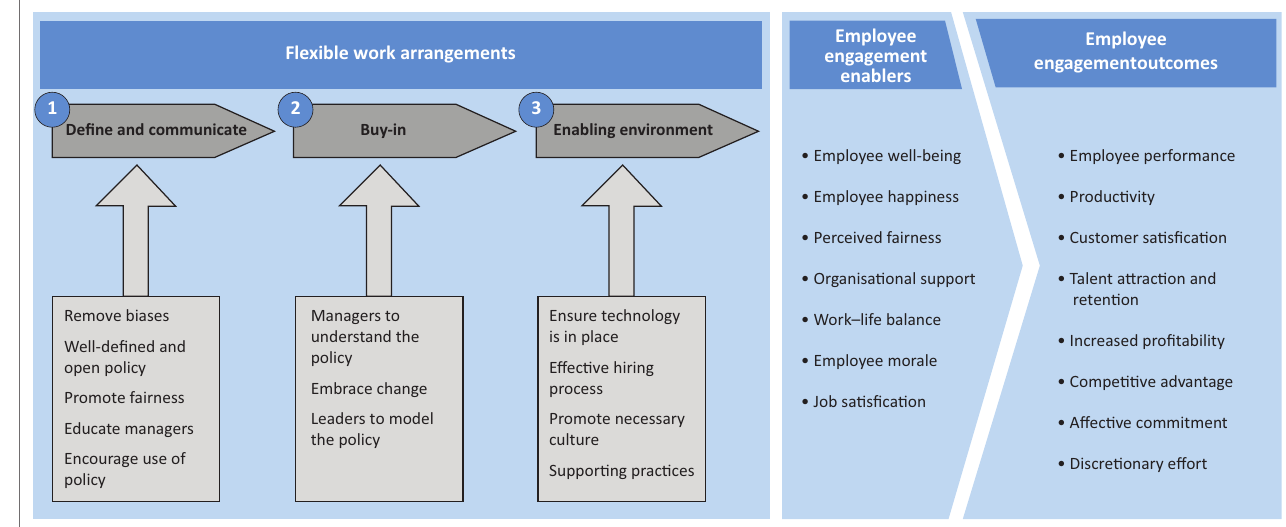
FIG URE 2: Flexible work arrangements